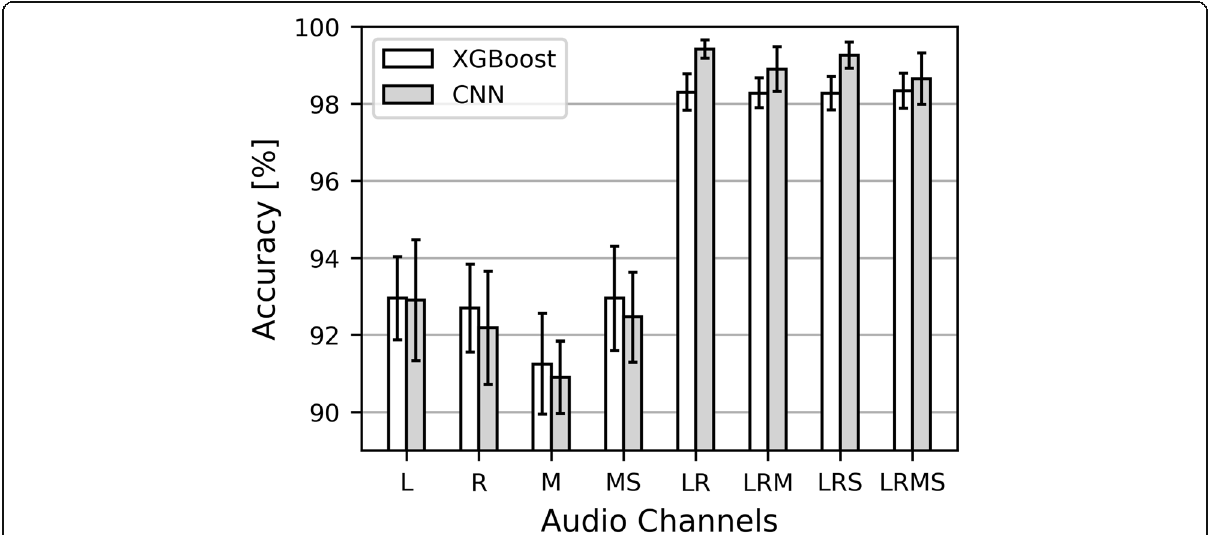
Fig. 11 The effect of audio channels on the discrimination results. Error bars denote standard